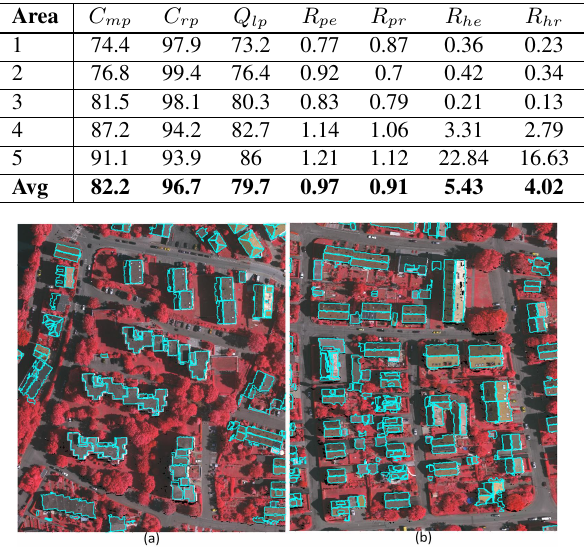
Figure 11: Extracted roof planes in the Vaihingen data set: (a) Area 1 and (b) Area 3.